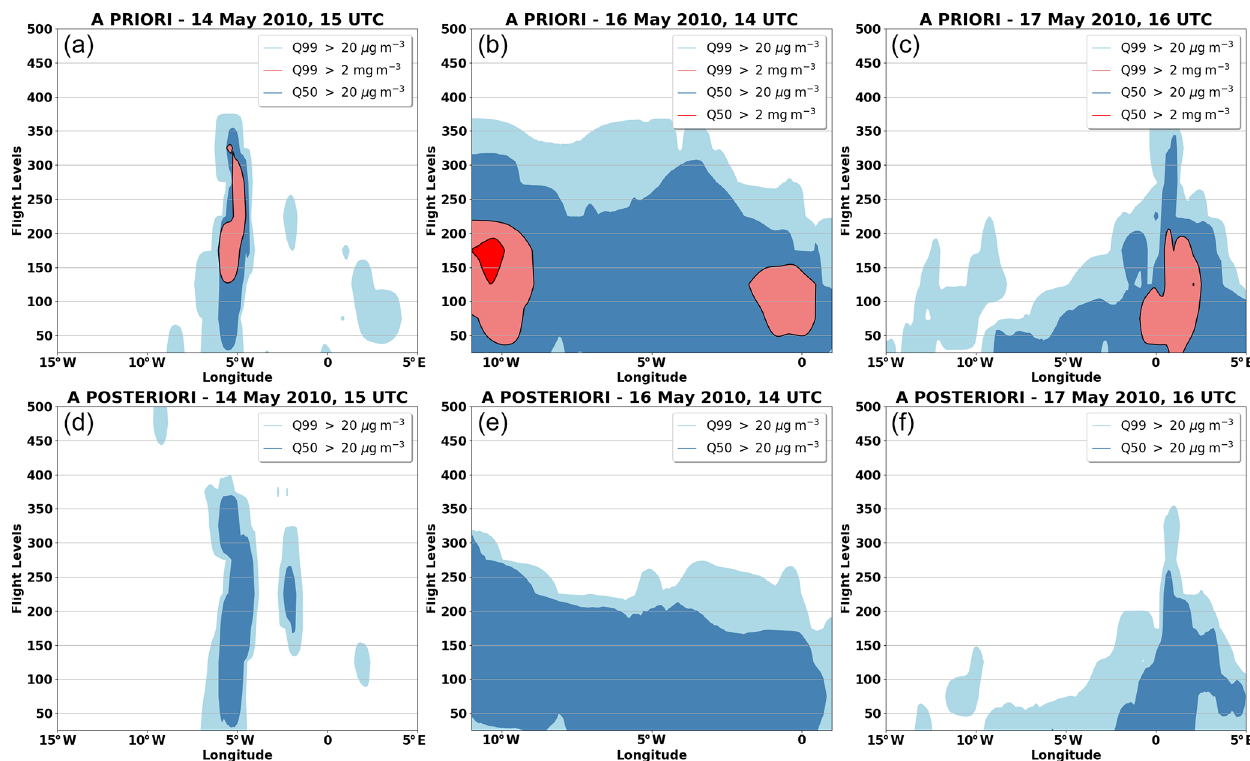
Figure 11. Ash concentrations from the a priori (a–c) and a posteriori (d–f) ensemble along the cross sections shown in Fig. 10. The dates and the colour legend are the same as in Fig.